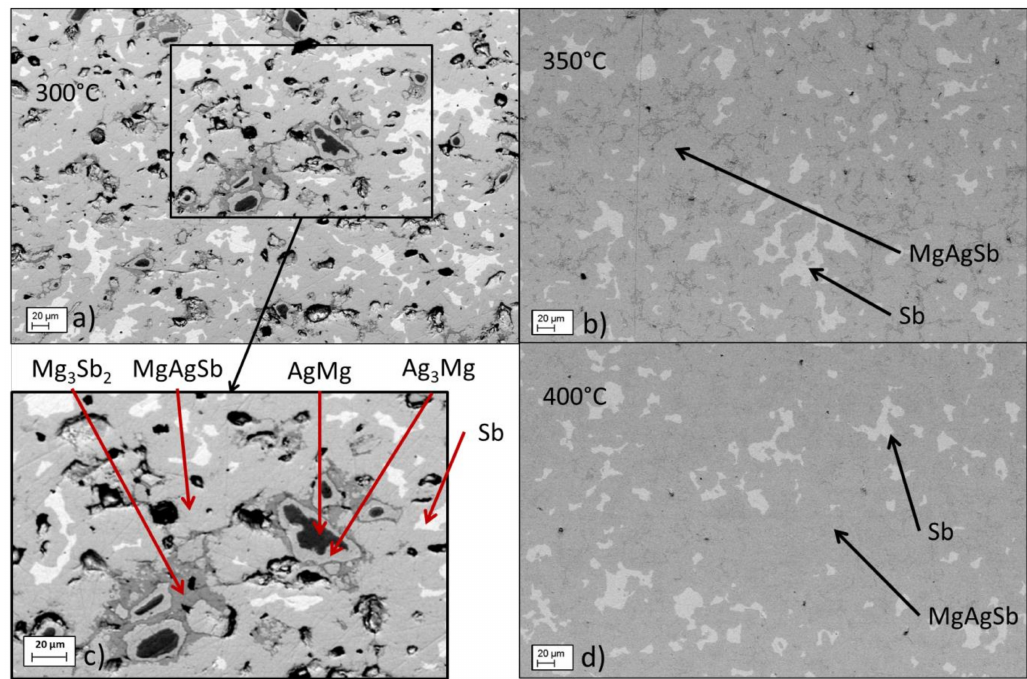
Figure 4. SEM images of the e ff ect of sintering temperature on the microstructure after planetary